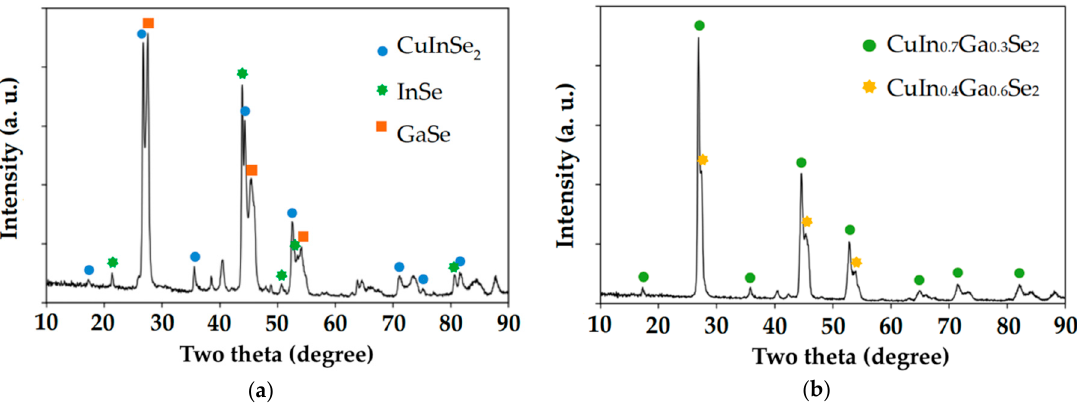
Figure 6. Grazing incidence XRD spectra of: ( a ) InSe–GaSe–Cu-based precursor layers and ( b ) the same sample after selenization.